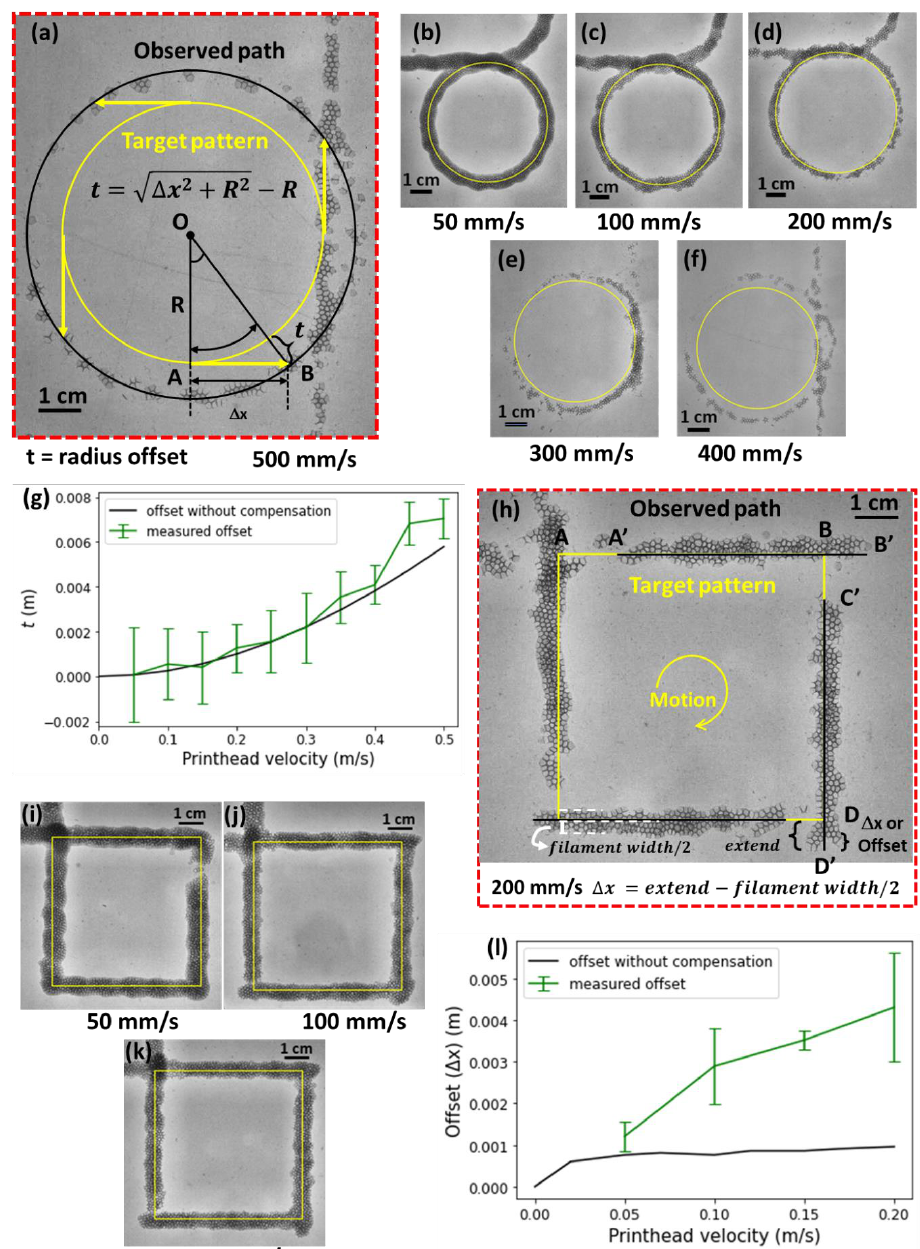
Figure 3. Observations and model results of the printed foam strands. ( a ) The observed printed bubbles stream (photo) for a printhead velocity of 500 mm/s. The yellow circle shows the preset circular nozzle path of 60 mm diameter while the black line shows the expected location of the printed foam strands. ( b – f ) Printed circles for increasing printhead velocities. ( g ) The radial offset, 𝑡 as a function of the printhead velocity. The green line shows measured mean values and the black line represents Equation (8). ( h ) The deposited bubble for a square geometry printed with a nozzle head velocity of 200 mm/s. The offset is shown as ∆ x , which was determined by extension beyond the yellow line (modeled path) after compensating the print thickness in the direction of motion of the printer. ( i – k ) Printed square patterns for increasing printhead velocities. ( l ) The measured and modeled offset ∆ x as a function of the printhead velocity for sharp corners. The error bars in ( g , l ) indicate the standard deviation of the offset, based on thickness